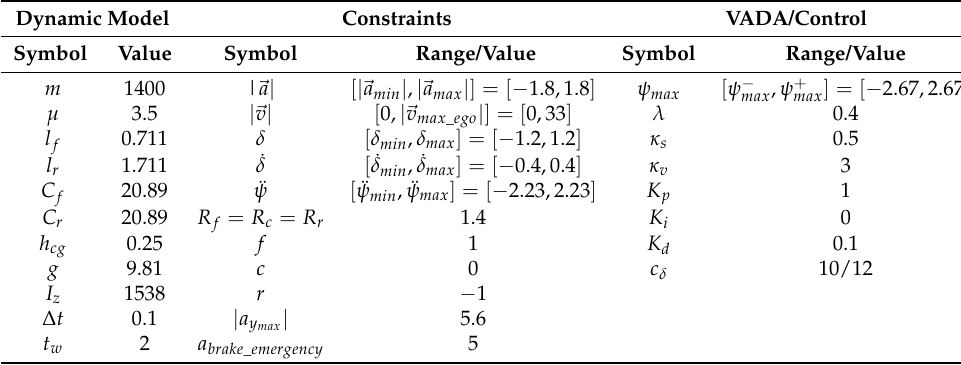
Table 4. Values and ranges for